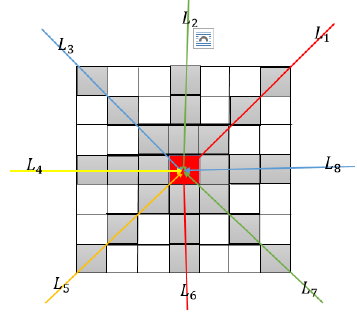
Figure 3. Matching cost aggregation in 8 paths Equation 1 is used to aggregate the matching costs in each path.